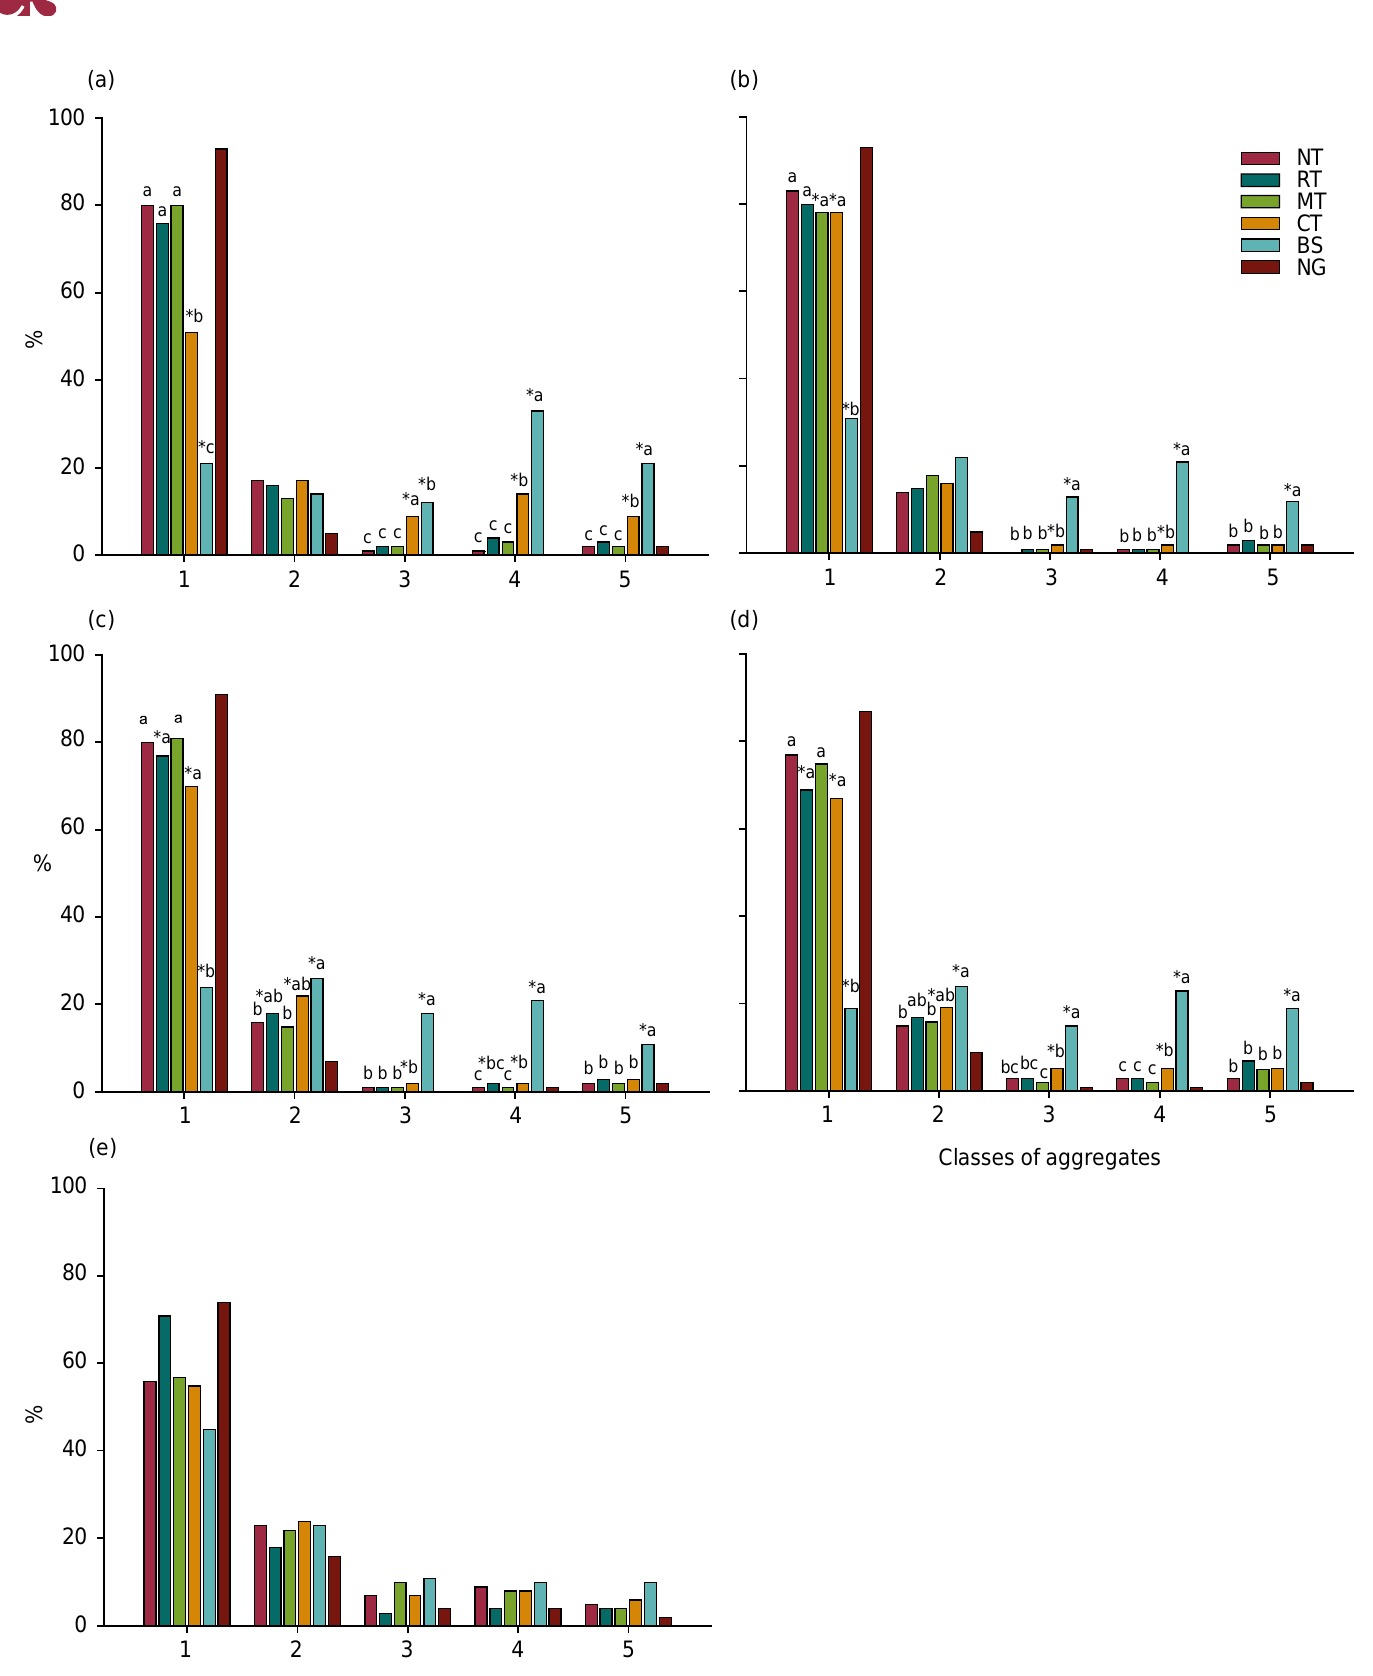
Figure 3. Distribution of the soil aggregates across 5 size classes (class 1: 6.375 mm; class 2: 3.375 mm; class 3: 1.500 mm; class 4: 0.625 mm; and class 5: 0.125 mm) at depths of 0.000-0.025 m (a), 0.025-0.050 m (b), 0.05-0.10 m (c), 0.10-0.20 m (d), and 0.20-0.40 m (e) in an Inceptisol after 27 years under various soil tillage methods: no-tillage (NT), rotating tillage (RT), minimum tillage (MT), conventional tillage (CT), bare soil (BS), and natural grassland (NG) as a reference. Note: Normality of the data by the Shapiro-Wilk test. The averages followed by (*) and/or by the same letter do not differ statistically from each other. We applied the Dunnett Test for comparison of the NG reference area with the treatments, and the Duncan Test for comparison among the five treatments at the 5 % probability